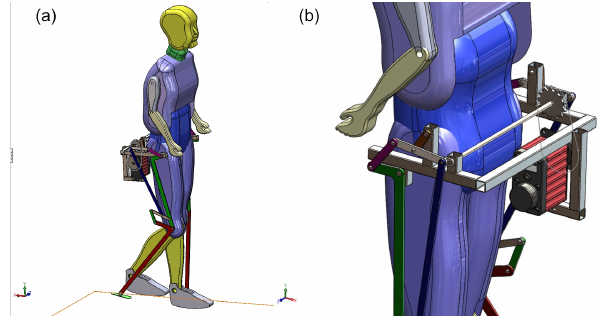
Figure 14. Exoskeleton virtual model worn by a human man- nequin: (a) right leg view; (b) left leg back